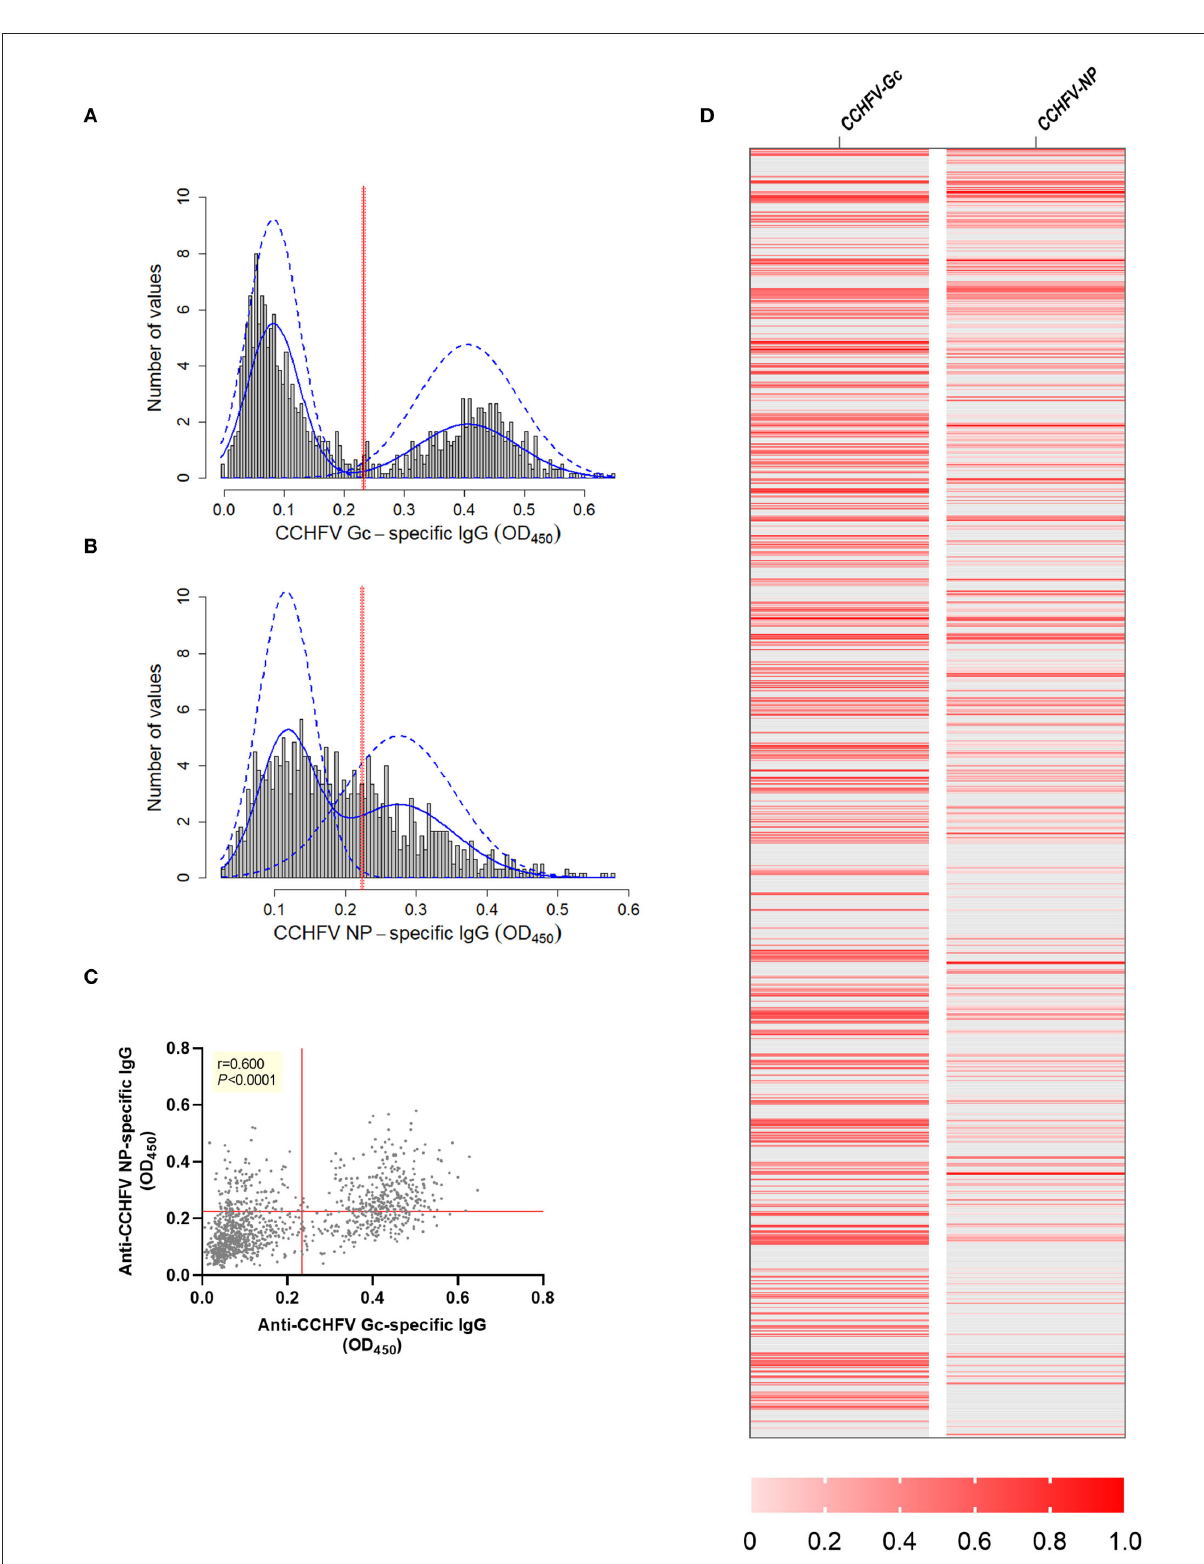
FIGURE1 CCHFV Gc-specific and CCHFV NP-specific IgG sero-reactivity in sheep sera from endemic CCHFV areas. Sheep sera were collected as part of a cross-sectional study in an endemic CCHFV area (Bulgaria, n = 1,200) and tested for anti-CCHFV Gc-specific IgG levels (A) and